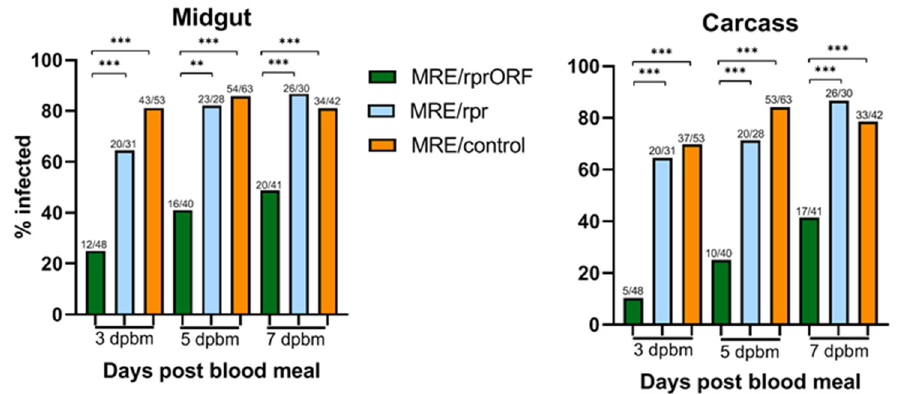
Figure 6. MRE/rprORF is less able to establish mosquito infection than MRE/rpr and MRE/control. Mosquitoes were fed blood containing MRE/rprORF, MRE/rpr, or MRE/control and dissected at 3, 5, or 7 days PBM. Midguts ( left ) and carcasses ( right ) were titered by TCID 50 . Mosquitoes that did not have detectable titer were considered to be negative while any positive titer by TCID 50 was considered to be positive. Numbers above each column indicate the positive/total sample numbers.